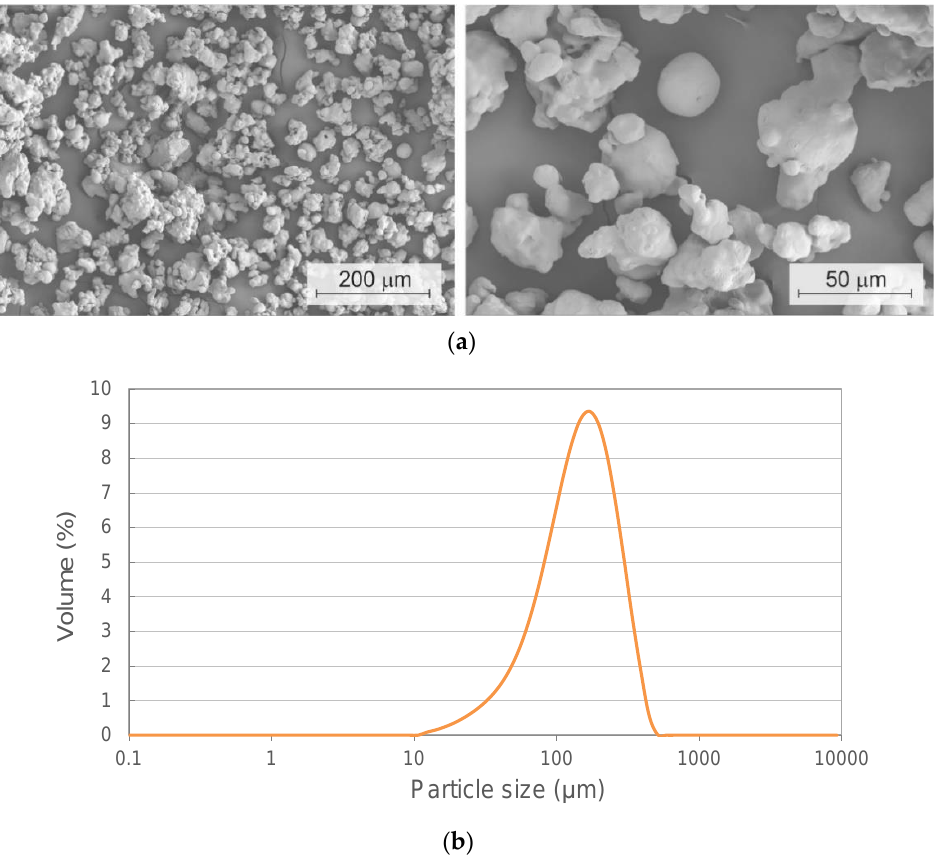
Figure 2. ( a ) Scanning electron microscopy (SEM) micrograph (FEI Teneo, FEI Company, Hillsboro, OR, USA) of the Fe WPL200 powder used in the MF-ERS experiments and conventional and double cycle PM consolidation. ( b ) Granulometric curve of the powder, showing a monomodal distribu- tion.